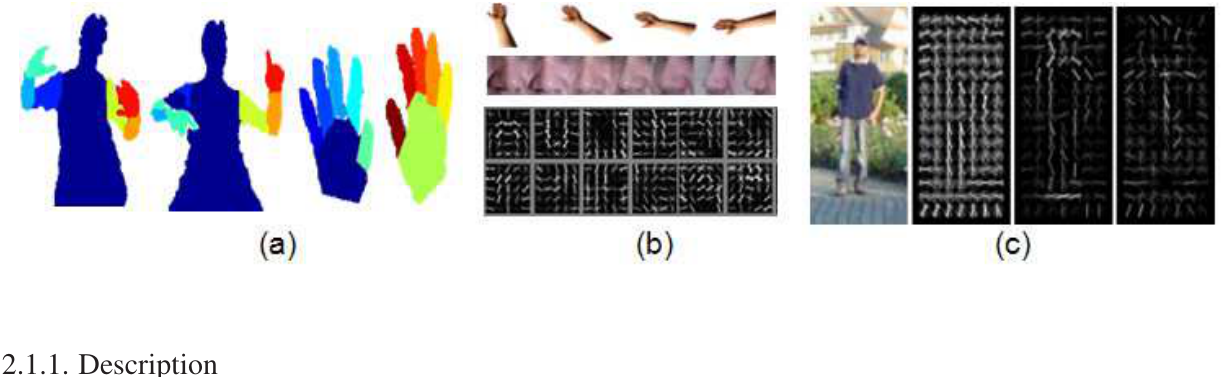
Figure 2. Examples of descriptors applied at pixel, local and global levels, respectively: ( a ) Graph cut approach for body and hands segmentation (frame extracted from [21]); ( b) Steerable part basis (frame extracted from [25]); and ( c ) Image of a person and its HOG descriptor, and this descriptor weighted by the positive and negative classification areas (frame extracted from